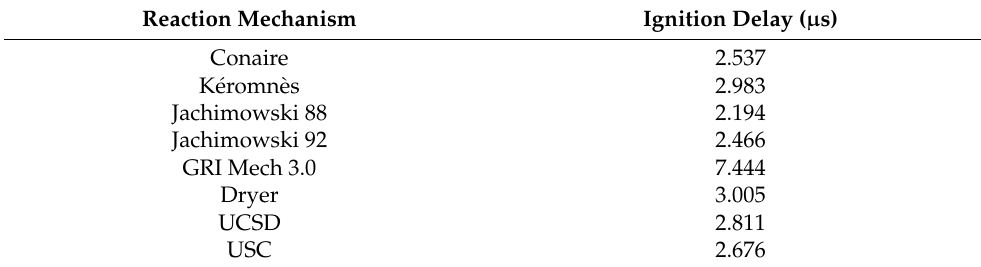
Table 1. Ignition delays calculated from the constant volume explosion model.